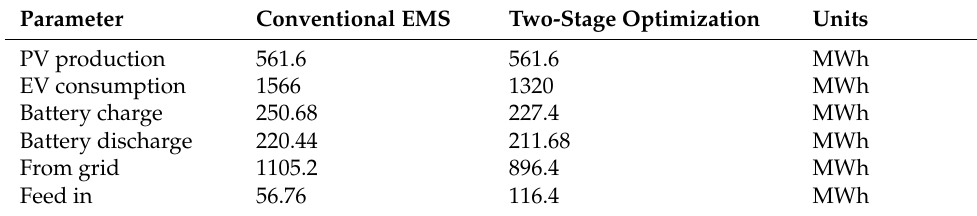
Table 3. Energy summary of the charging